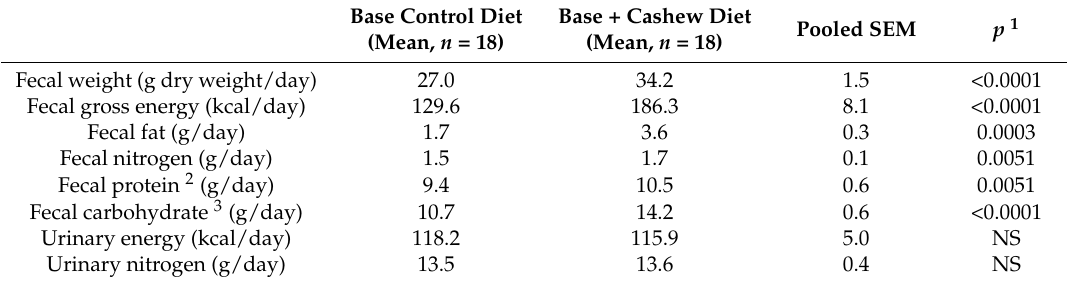
Table 4. Composition of excreta for the Base Control Diet and the Base + Cashew Diet. Base Control Diet (Mean, n =